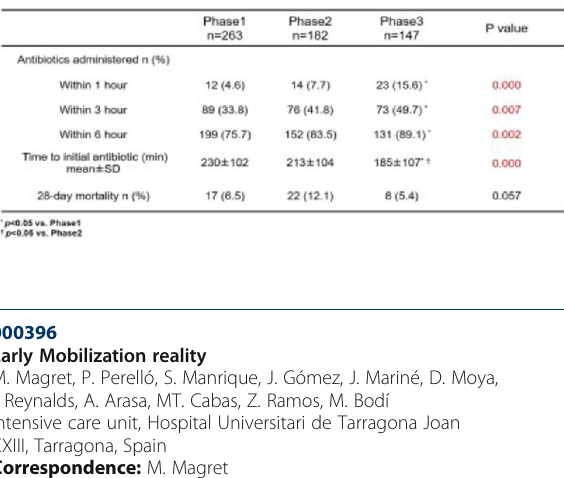
Table 2 (abstract 000343). Clinical